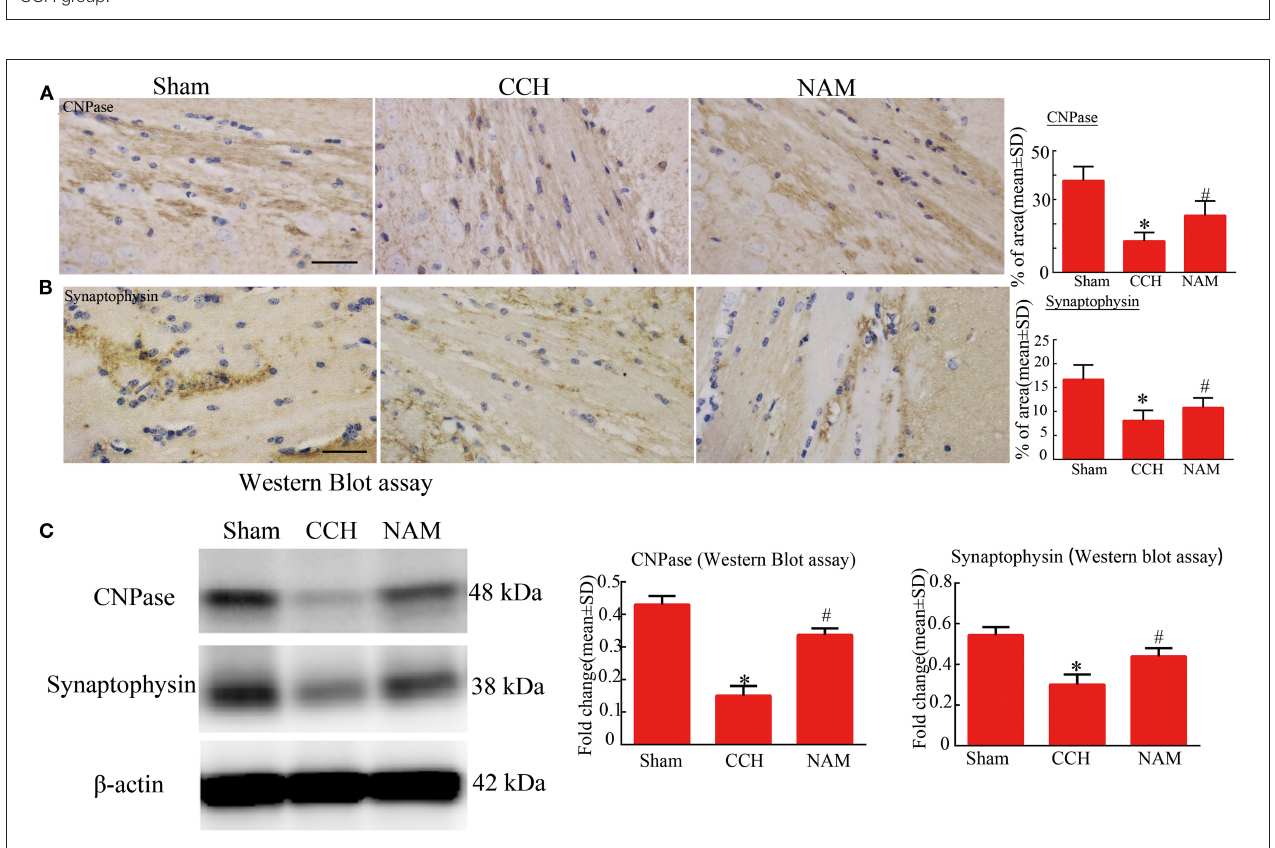
FIGURE 4 | Effect of NAM on histological changes in white matter ( n = 4/group). (A) : Vacuole area as determined via H&E staining (scale bar = 100 µ m); and (B) : Degree of white matter damage as revealed by Kluver-Barrera staining (scale bar = 100 µ m). * p < 0.05, compared with sham group; # p < 0.05, compared with CCH group.